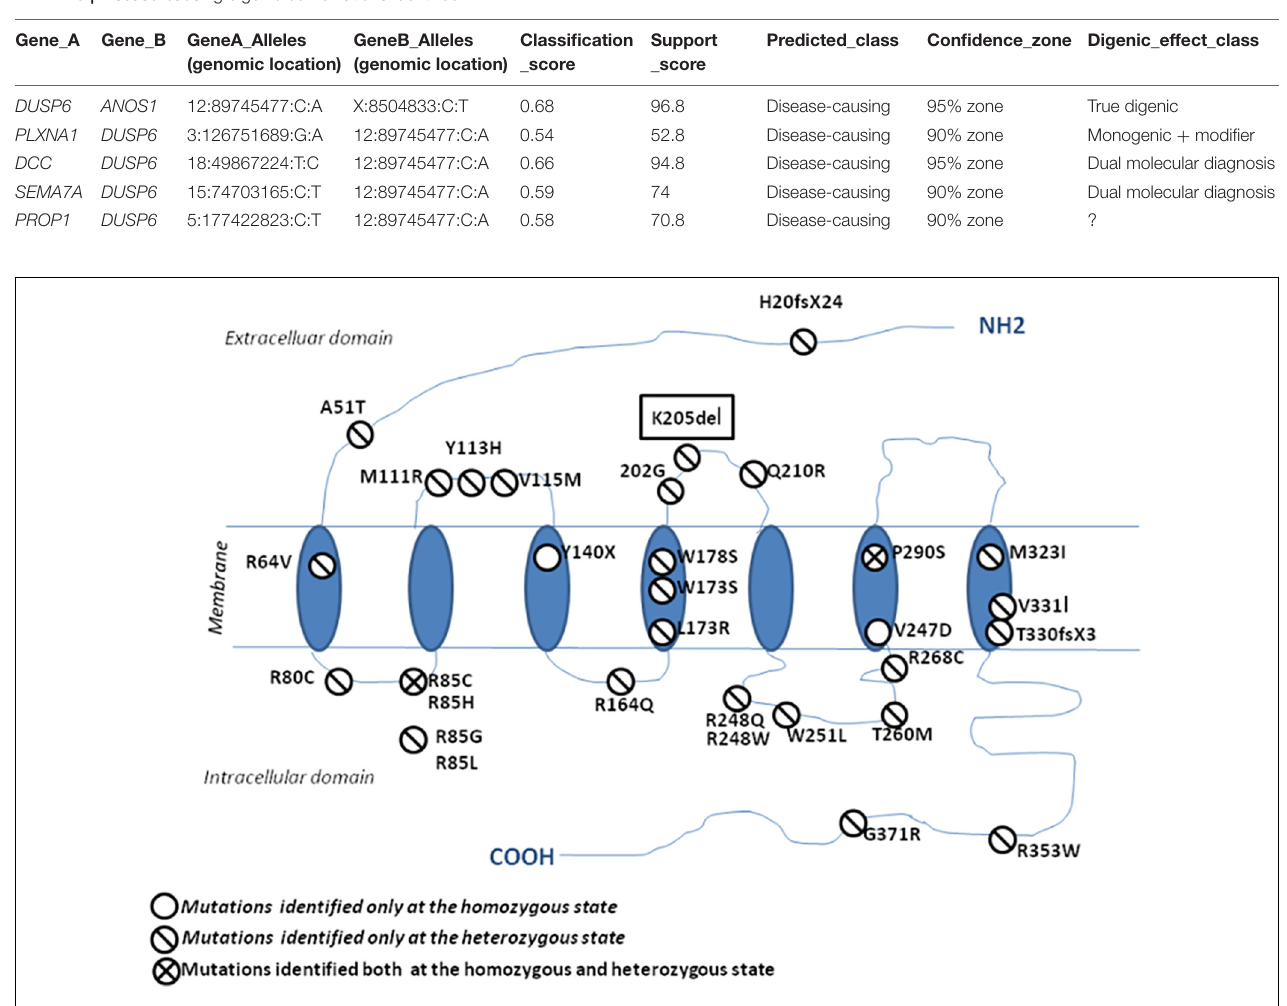
FIGURE 5 | Schematic representation of the protein localization of PROKR2 genetic variations. The genetic variations identified at a heterozygous state are shown with a one-bar circle, the genetic variations identified at both homozygous and heterozygous states are shown with a two-bar circle, and the genetic variations identified only at a homozygous state are shown with an empty